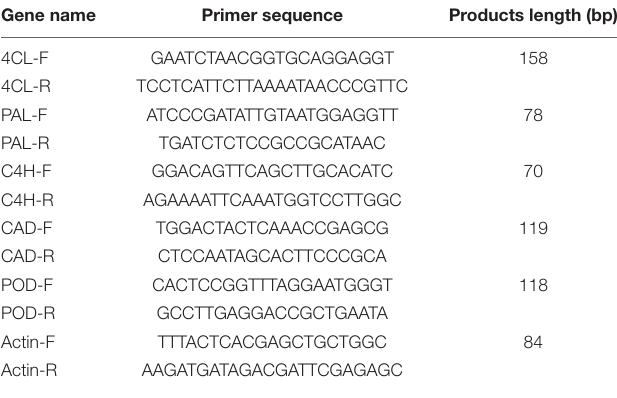
TABLE 1 | Primer sequences and amplification products were used in this study.